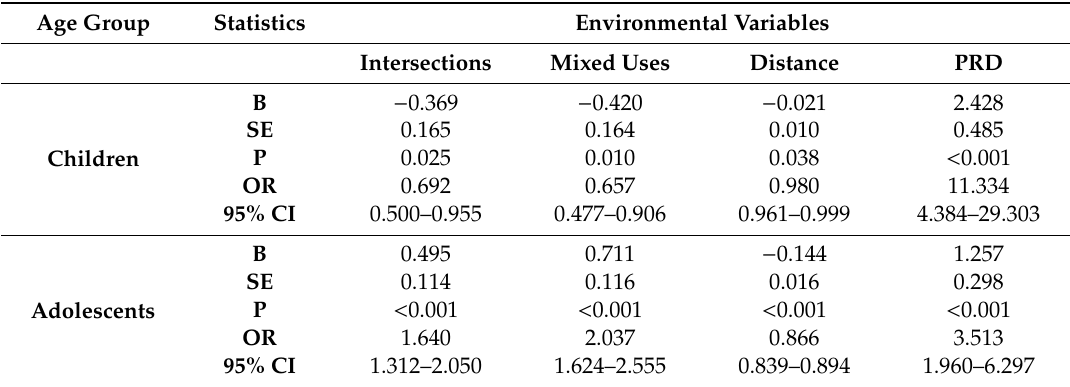
Table 3. Predictors of ACS separately for children and adolescents using binary logistic regression (BLR) (model